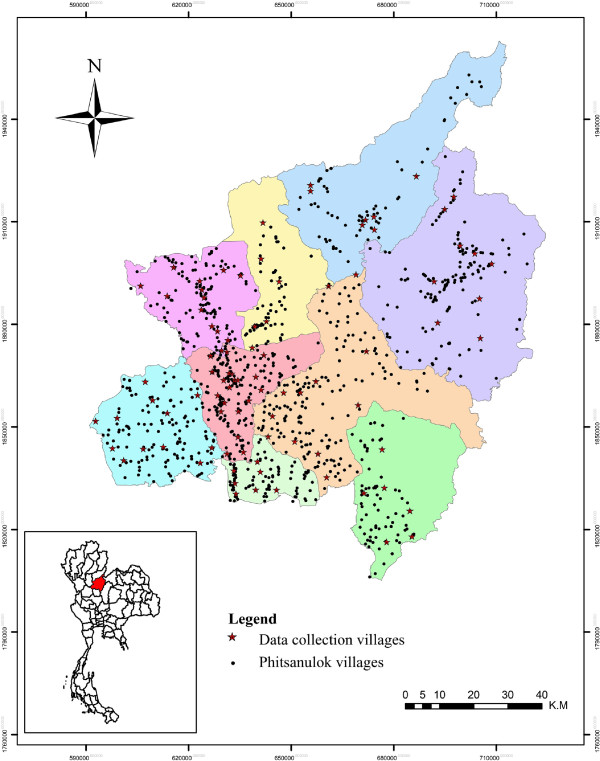
Phitsanulok Province with district boundaries (study area). Inset box shows location of Phitsanulok Province (red) in Thailand. Red stars indicate the 92 villages which were sampled three times (i.e. March, May and July) during 2009. Dots indicate all the villages in Phitsanulok Province. Total area of Phitsanulok is approximately 10,816 km2.